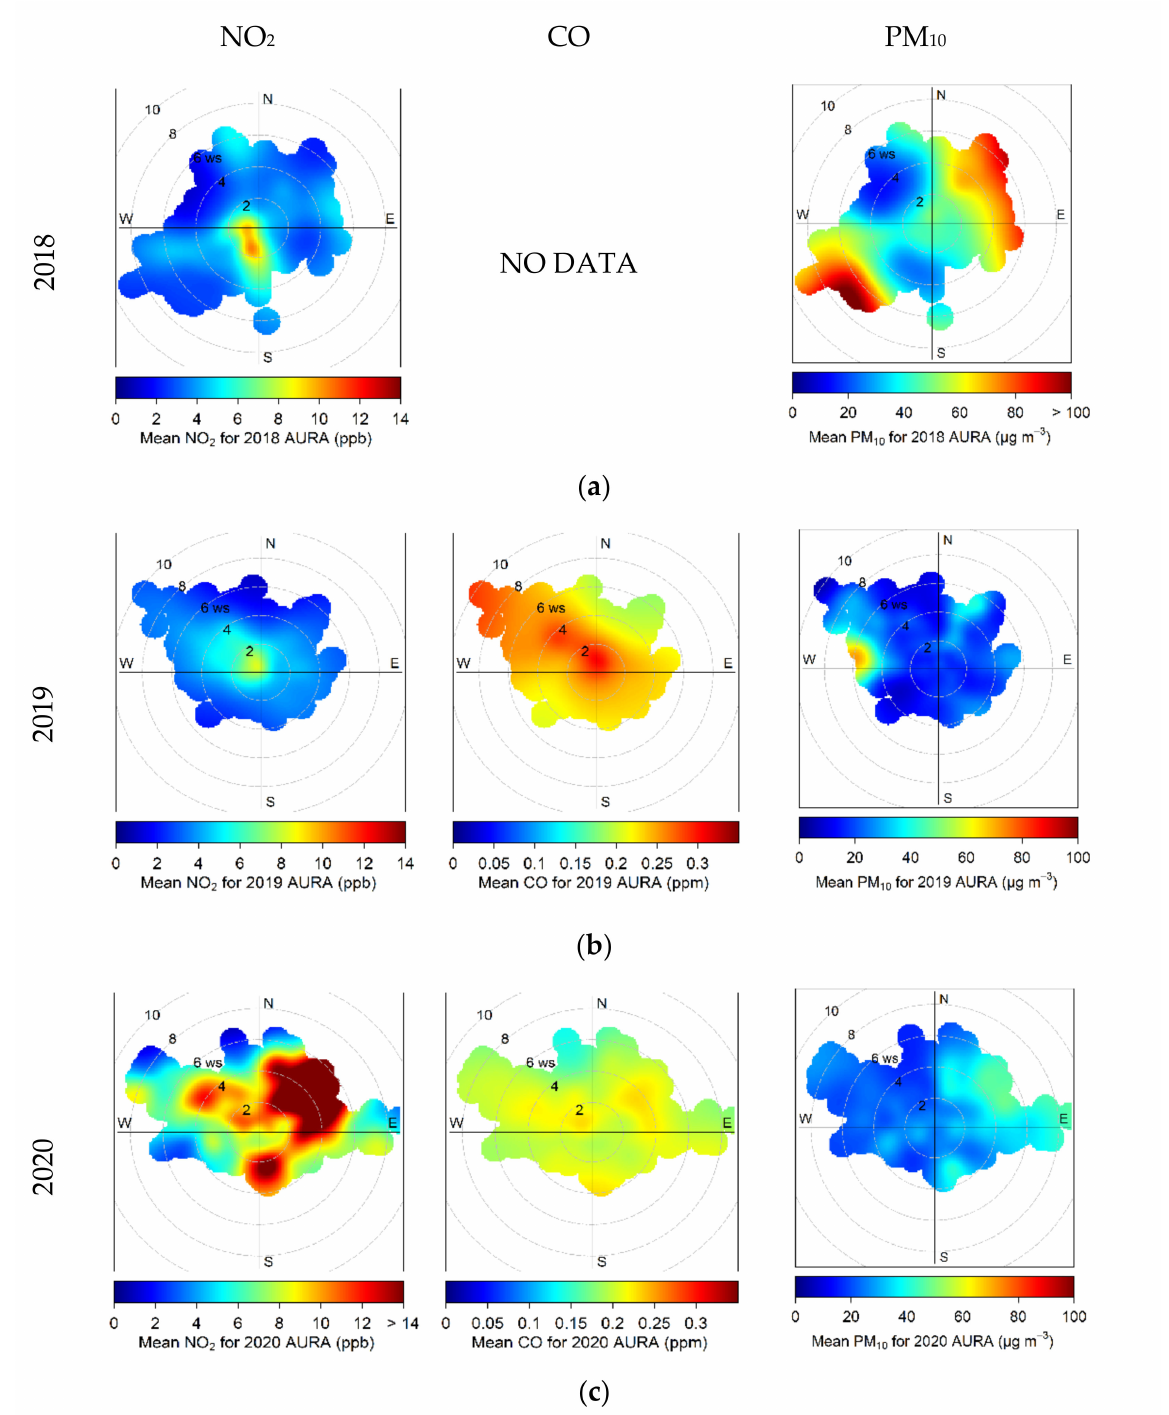
Figure 12. The respective bivariate polar plots for the three main pollutants NO 2 (left column), CO (centre column) and PM 10 (right column) of the AURA station for ( a ) 2018, ( b ) 2019 and ( c ) 2020 for the lockdown